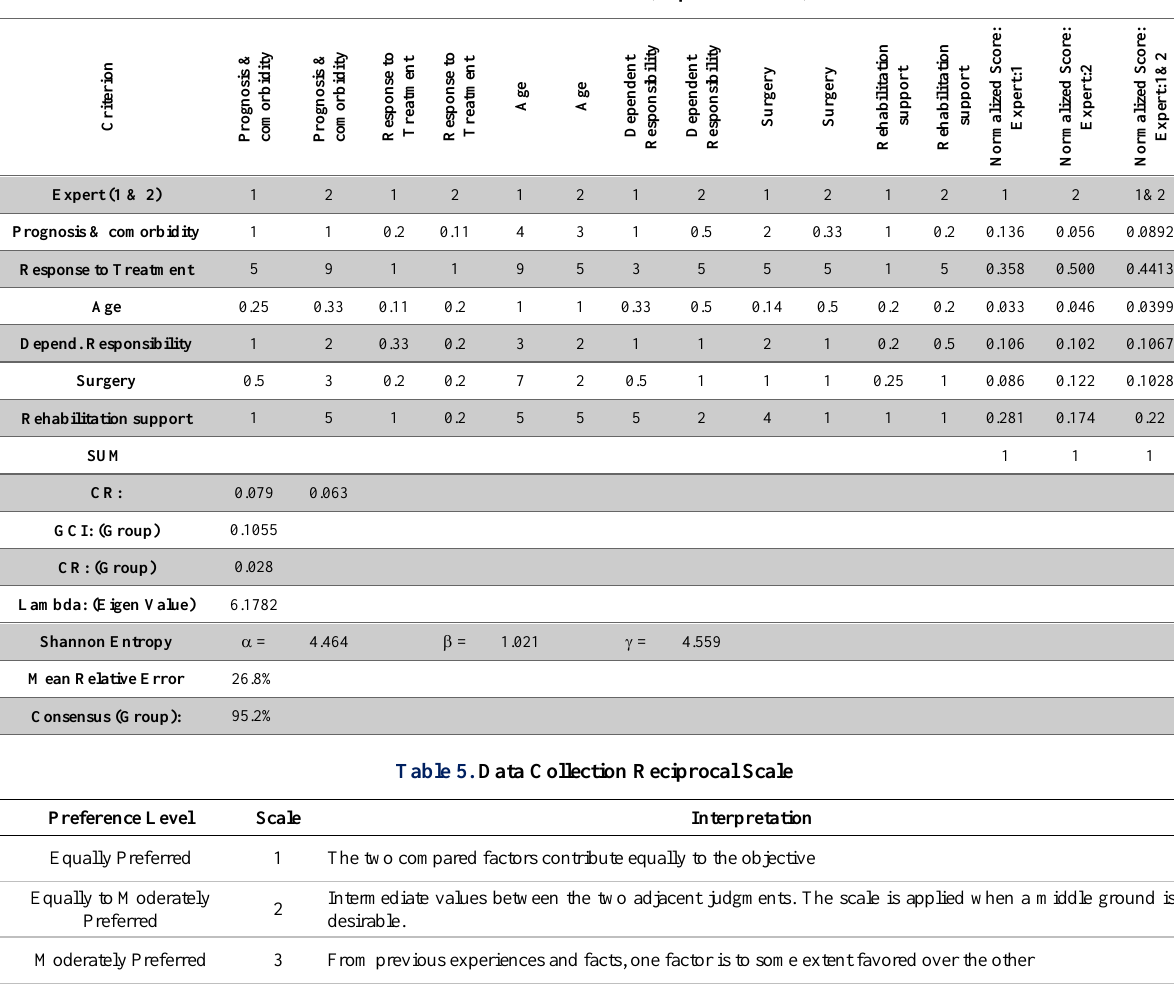
Table 4. Decision Matrix A (Expert: 1 and 2)